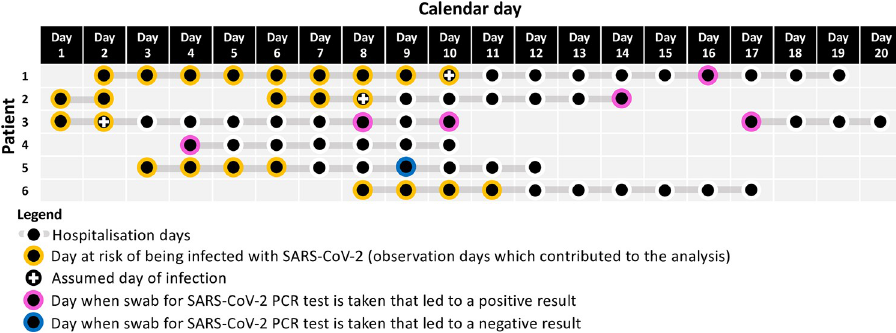
Fig 1. Illustration of assumed incubation periods and the data analysed for 6 example patients. We assumed that PCR tests were performed 1 day after developing symptoms, which were consistent with COVID-19. In this schematic, an incubation period of 5 days was used. Each hospitalised patient day from admission until (and including) the day of the assumed infection event (i.e., 6 (incubation period plus 1) days prior to the swab leading to the patient’s first positive PCR test) or 6 days prior to the day of discharge or death (whichever occurred first) was considered an observation where the patient was at risk of becoming infected. Each observation, unique to a specific patient on a specific day, therefore corresponds to an outcome 6 days later when the patient could potentially have a swab taken for a SARS-CoV-2 PCR test. An observation had a positive outcome (value of 1) if the patient had a positive PCR test for the first time resulting from a swab taken in the hospital 6 days later, and a negative outcome (value of 0) if the patient did not have a swab taken or had a swab taken resulting in a negative PCR test 6 days later. The risk factors, e.g., ward, number of infectious patients, or HCWs in the same ward, for each observation were taken from the day of the observation itself when the corresponding patient was at risk of becoming infected. COVID AU : AbbreviationlistshavebeencompiledforthoseusedinFigs 1 (cid:0) 5 : Pleaseverifythatallentriesarecorrect : -19, Coronavirus Disease 2019; HCW, healthcare worker; SARS-CoV-2, Severe Acute Respiratory Syndrome Coronavirus